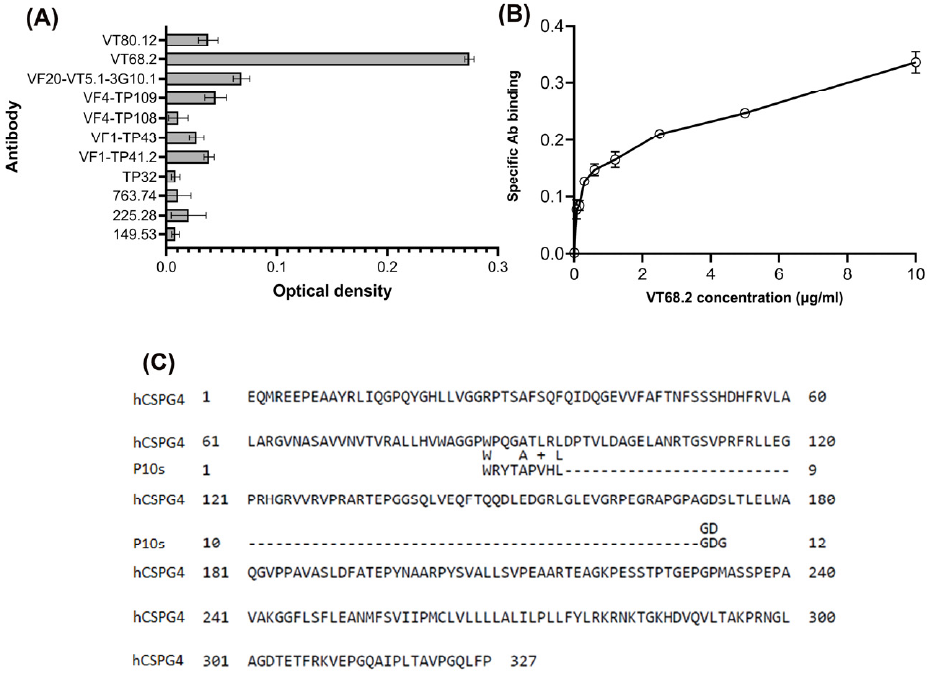
Figure 2. Binding of anti-CSPG4 mAbs to P10s. Anti-CSPG4 mAb VT68.2 showed stronger